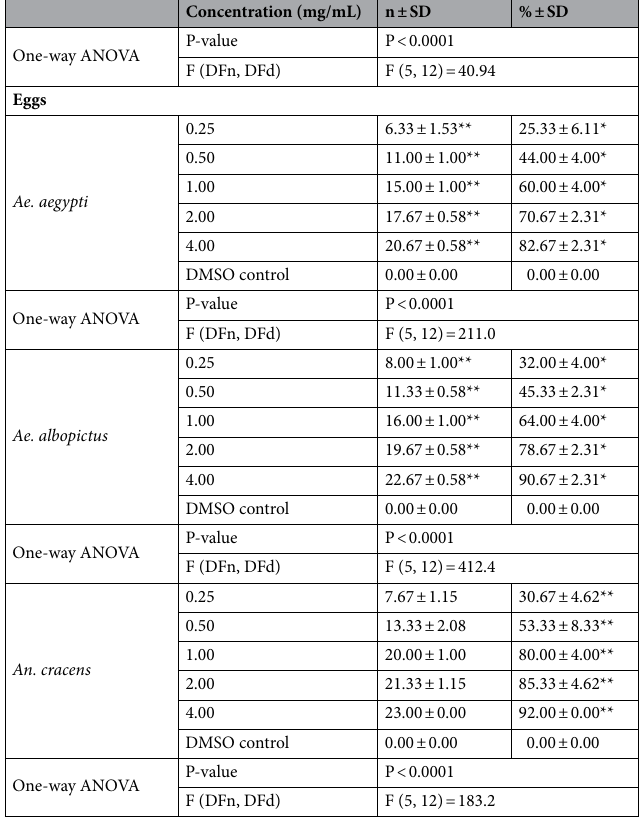
concentrations were associated with significant mortality in Ae. aegypti adults (one-way ANOVA and Dunnett’s test). As detailed in Table 1, the EA extract of Streptomyces sp. KSF103 was also effective against the adults of An. cracens , showing an LC50 of 5.121 mg/mL while the LD 90 was 147.854 mg/mL. A one-way ANOVA test found a significant effect of the EA extract treatment (P < 0.0001). A post hoc Dunnett’s test discovered significant differ- ences in mortality rate between all concentrations of the treatment groups and the DMSO-only control group. Adults from the control groups without the EA extract addition survived. Ovicidal activity and determination of lethal concentrations. The ovicidal activities of Streptomy- ces sp. KSF103 EA extract on the eggs of Ae. aegypti , Ae. albopictus , and An. cracens are summarised in Table 1. The EA extract was highly lethal to the eggs of all of the species tested in a concentration-dependent pattern (Fig. 2c). The highest mean mortality was shown by An. cracens , followed by Ae. albopictus and Ae. aegypti at concentrations of 0.25, 0.5, 1, 2 and 4 mg/mL. After 168 h post-treatment, the EA extract exhibited 90.67% ovicidal efficacy against Ae. albopictus at a concentration of 4 mg/mL. While at the lowest concentration of 0.250 mg/mL of the EA extract, 32.00% egg mortality was observed in Ae. albopictus . The EA extract showed a LC 50 value of 0.559 mg/mL and LC 90 value of 2.609 mg/mL at 168 h post-treatment. Ae. aegypti eggs were more tolerant to the EA extract of Streptomyces sp. KSF103 at all concentrations. After 168 h post-treatment, 82.67% ovicidal activity was noticed at the highest concentration of 4 mg/mL, whereas the lowest concentration of 0.250 mg/mL demonstrated 25.33% of ovicidal activity in Ae. aegypti . Corresponding to the mortality rate, the highest LC 50 and LC 90 values were recorded at 0.441 and 6.956 mg/L, respectively Ovicidal bioassays conducted on An. cracens eggs showed that the Streptomyces sp. KSF103 EA extract had the most toxic ovicidal activity, with an LC 50 value of 0.441 mg/mL and an LC 90 value of 2.609 mg/mL. In three of these species tested, a one-way ANOVA showed a significant difference between the groups (P < 0.0001), and a post hoc Dunnett’s test revealed further statistically significant differences when each concentration was compared to the DMSO-only control (Table 1). In the DMSO-only control, the hatchability of eggs of all of the species was normal. The overall results revealed that the mortality rate increased with increased extract concentrations.